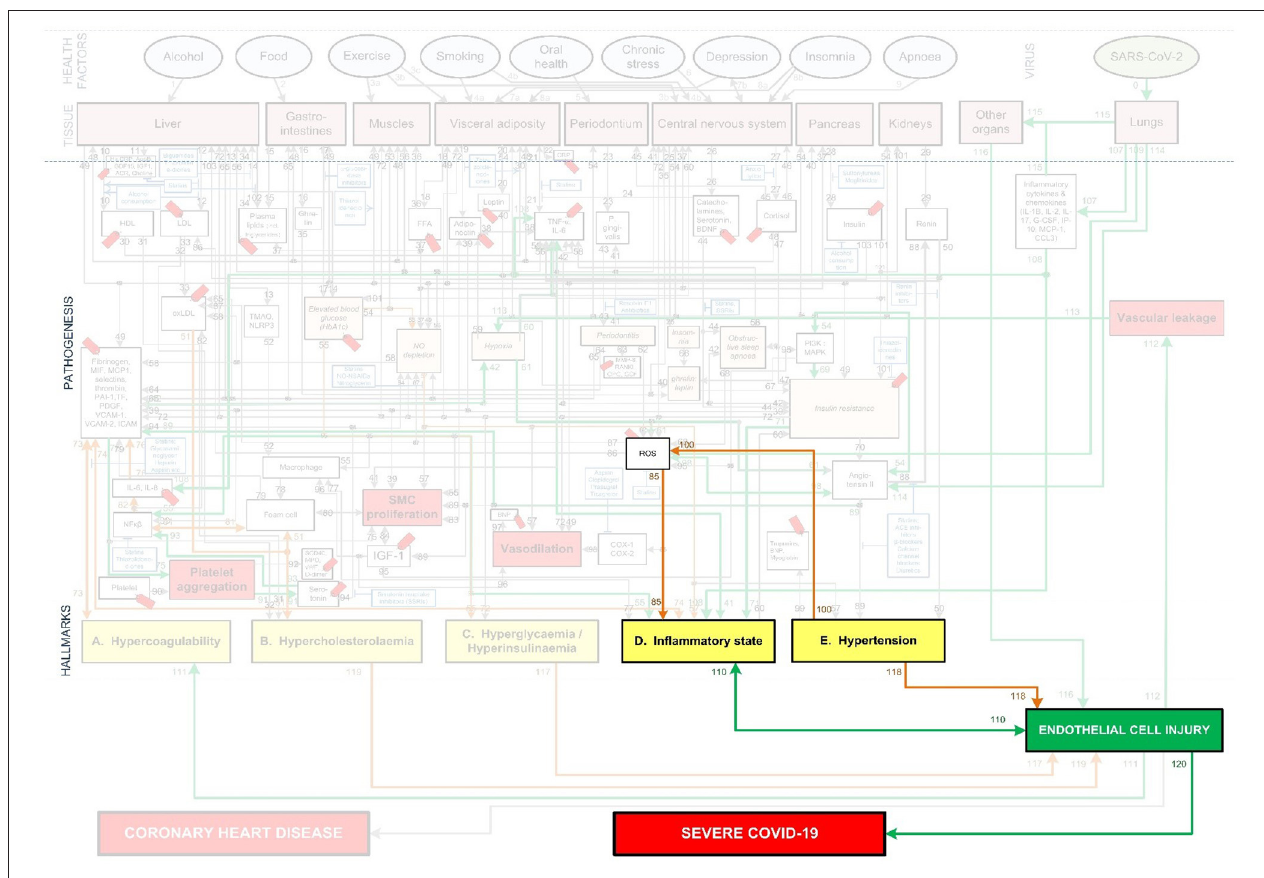
FIGURE 10 | CHD related aggravation of severe Covid-19 in patients with chronic hypertension.